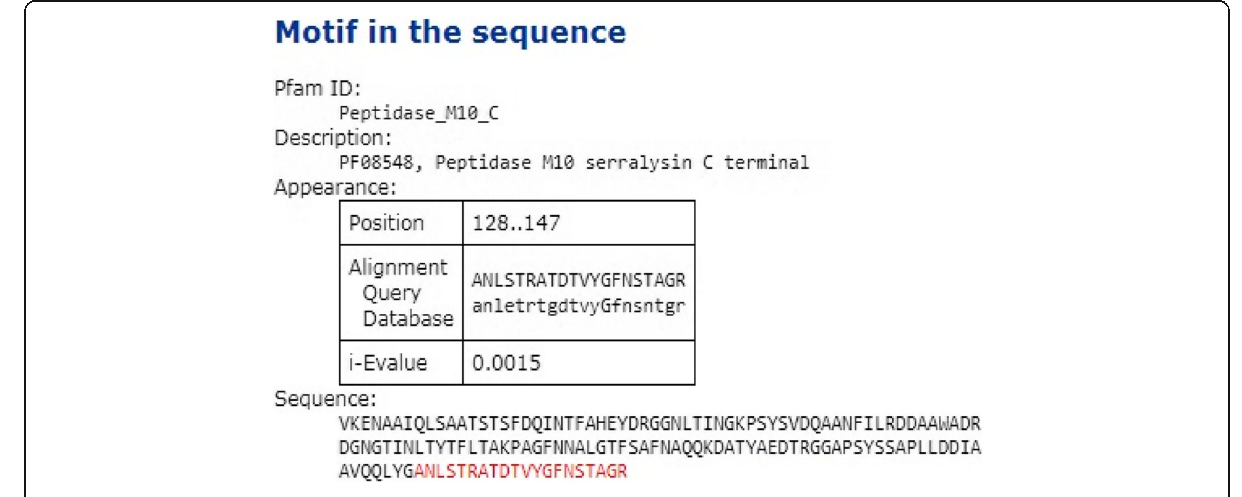
Fig. 13 Motif matches of